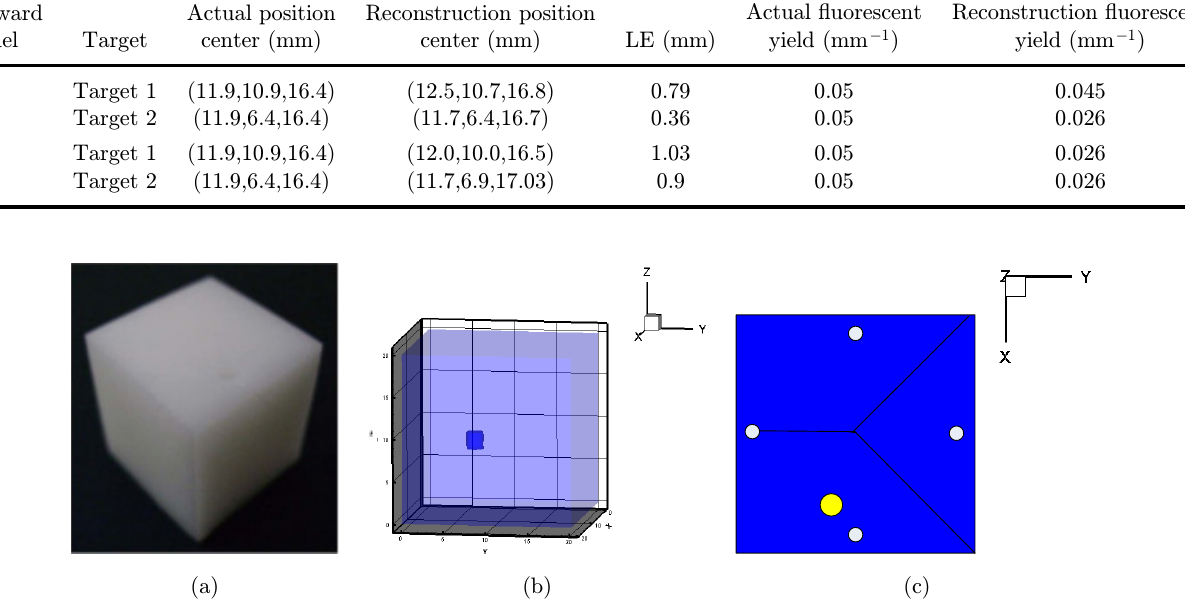
Fig. 7. Physical phantom. (a) The 3D view of the single °uorescent target in the cubic phantom. (b) The 3D view of the single °uorescent target in the cubic phantom. (c) The x – y view on the z ¼ 10-mm plane, where the white dots represent the excitation point source positions.